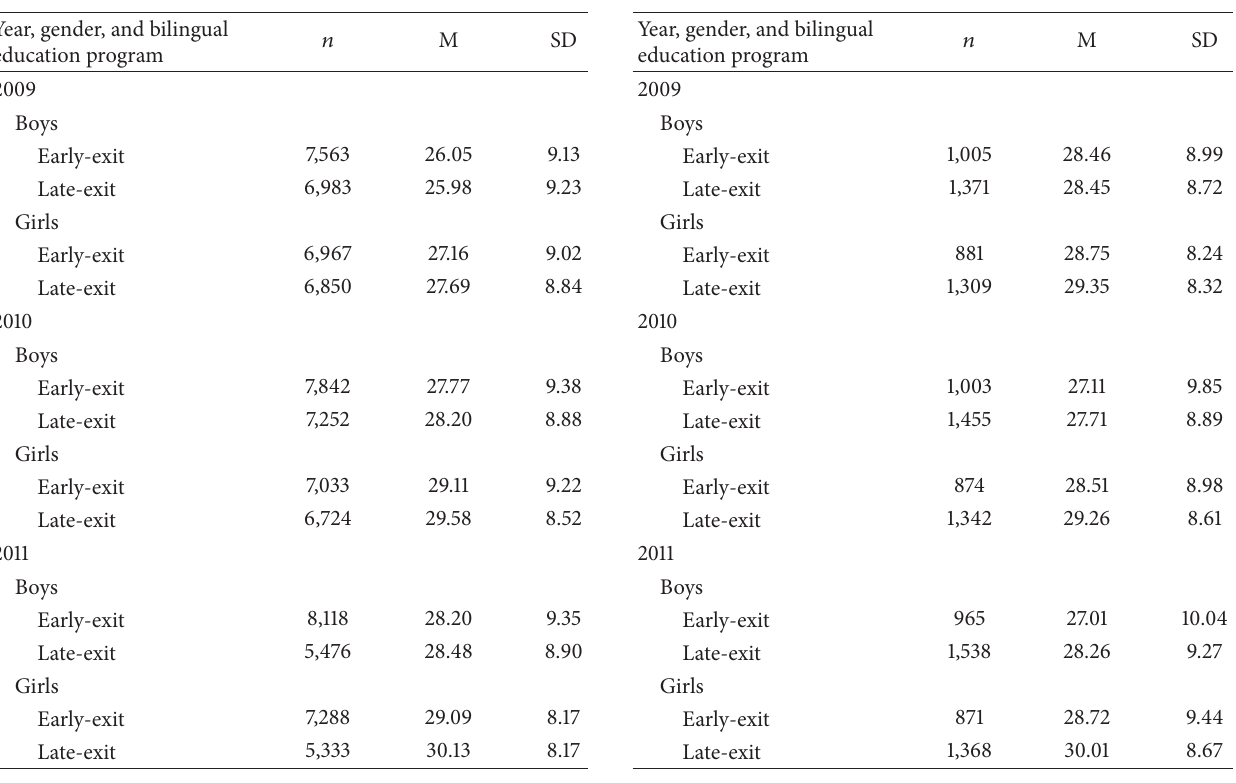
Table 3: Descriptive statistics for the 2009, 2010, and 2011 TAKS Reading scores for Grade 5 boys and girls by bilingual education program.